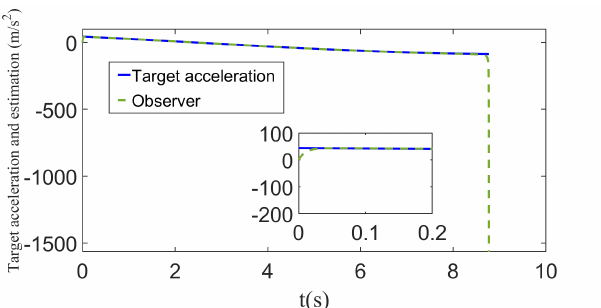
Figure 5. The target’s acceleration a T